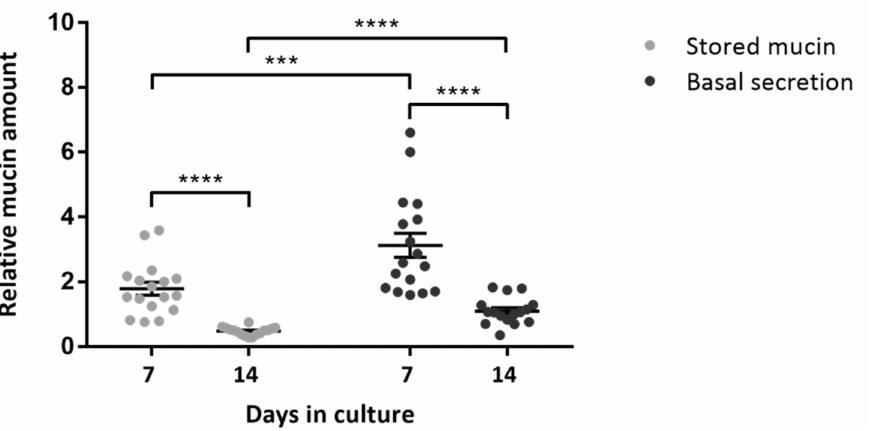
(Figure 1, Mann–Whitney test, p -value < 0.0001) during the culture period. In contrast, the basal mucin secretion remains elevated over the intracellular storage levels at 7 days in culture (DIC) (Figure 1, Wilcoxon test, p -value = 0.0001) and 14 DIC (Figure 1, paired t -test, p -value < 0.0001).